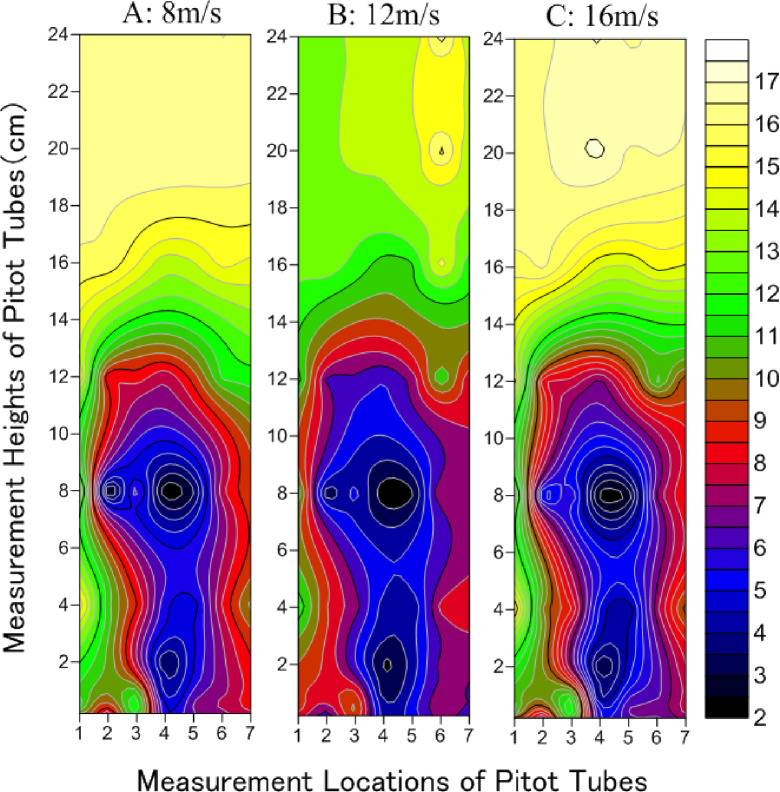
Distribution characteristics of airflow field in spindle-shaped synthetic shrubs under wind speeds of 8, 12 and 16 m/s.(Numbers 1–7 of horizontal axis correspond to -8.75 (the windbreak front), 8.75, 26.25 (within the windbreak), 43.75, 52.5, 87.5 to 122.5 cm (downwind of windbreak), respectively).